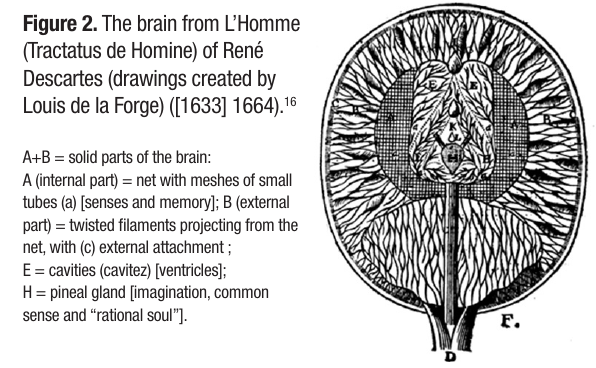
Figure 2. The brain from L’Homme (Tractatus de Homine) of René Descartes (drawings created by Louis de la Forge) ([1633] 1664).